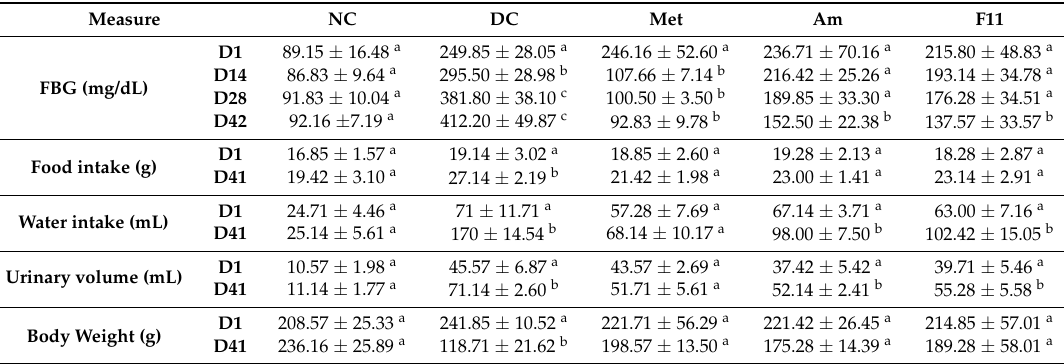
Table 2. Changes in fasting blood glucose and metabolic parameters.